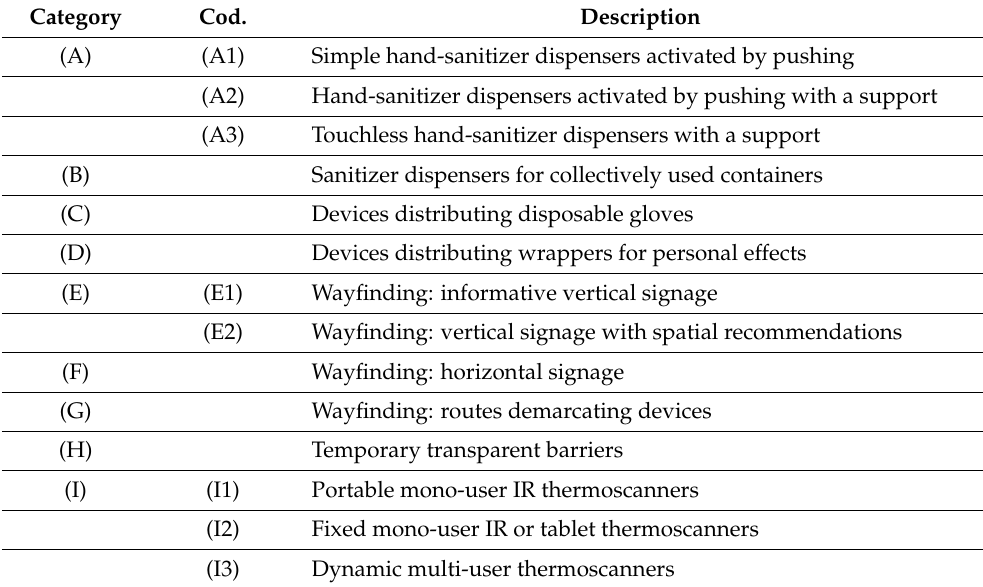
Table 8. Classification of the prevention measures implemented in the considered facilities. Own processing. Category